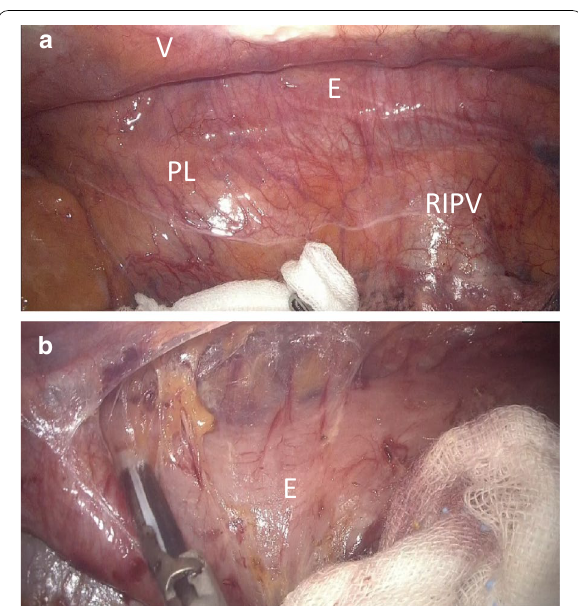
Fig. 6 Thoracoscopic intraoperative findings of Patient 2. a Esophagus can be seen from a top-down view. b Dissection of the dorsal side of esophagus. The operative field visibility was better than that in patient 1 . V Vertebra, PL pulmonary ligament, RIPV right inferior pulmonary vein, E